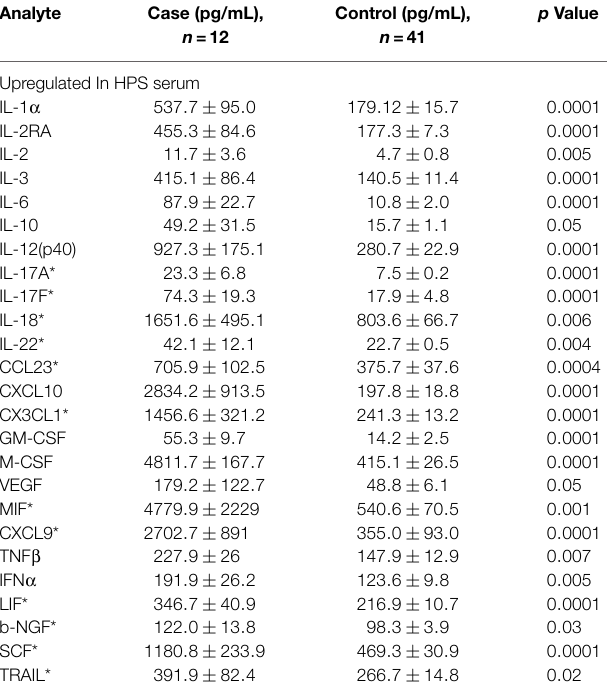
TABLE 2 | Cytokines upregulated in HPS cases compared to healthy controls .